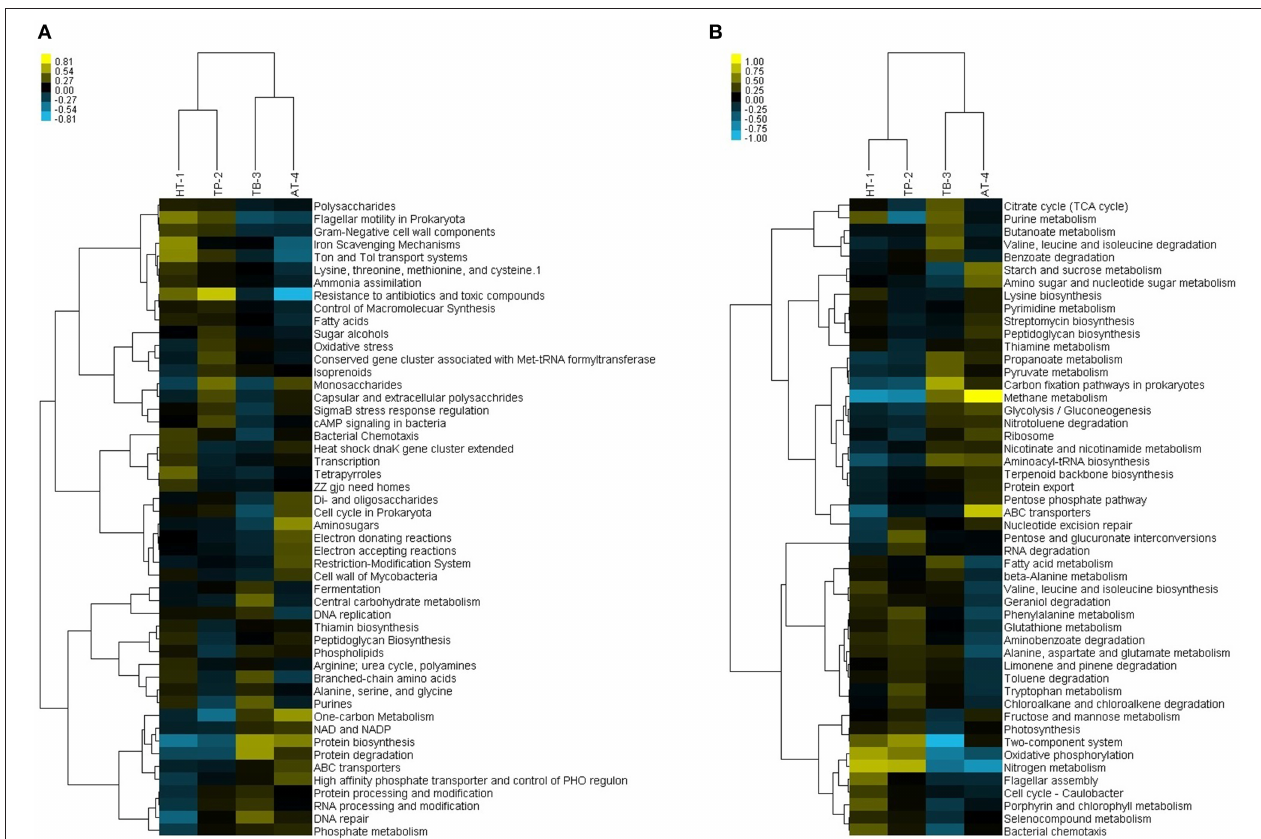
FIGURE 5 | Two-way hierarchical clustering analyses of the hot springs vs. metagenomes based on relative percentage of gene sequences with matches to different SEED subsystems and KEGG pathways. (A) Clustering of hot springs vs. SEED subsystem functions. Subsystems with a standard deviation greater than 0.1 of the observed values, having at least three samples with ≥ 0.4% of the total sequences are shown. (B) Clustering of hot springs vs. KEGG pathways. Pathways with a standard deviation greater than 0.1 of the observed values, having at least three samples with ≥ 0.3% of the total sequences are